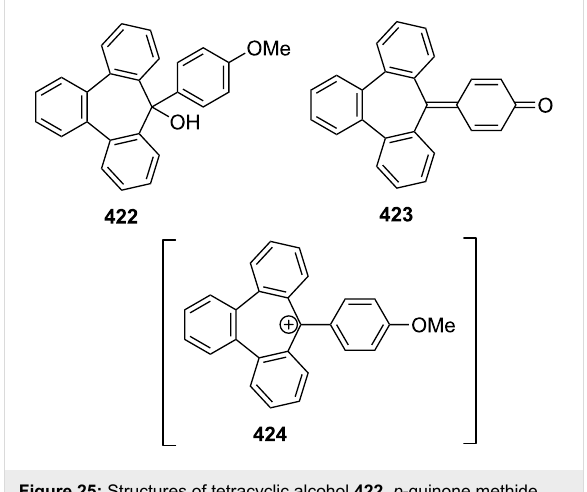
Figure 25: Structures of tetracyclic alcohol 422 , p -quinone methide 423 and cation 424